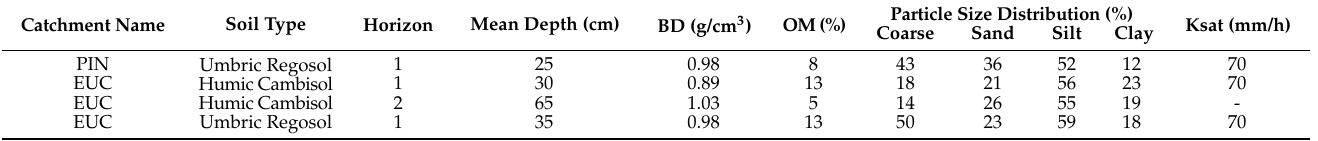
Table 2. Soil types and physical characteristics in both Lourizela (PIN) and Serra de Cima (EUC) study areas. Catchment